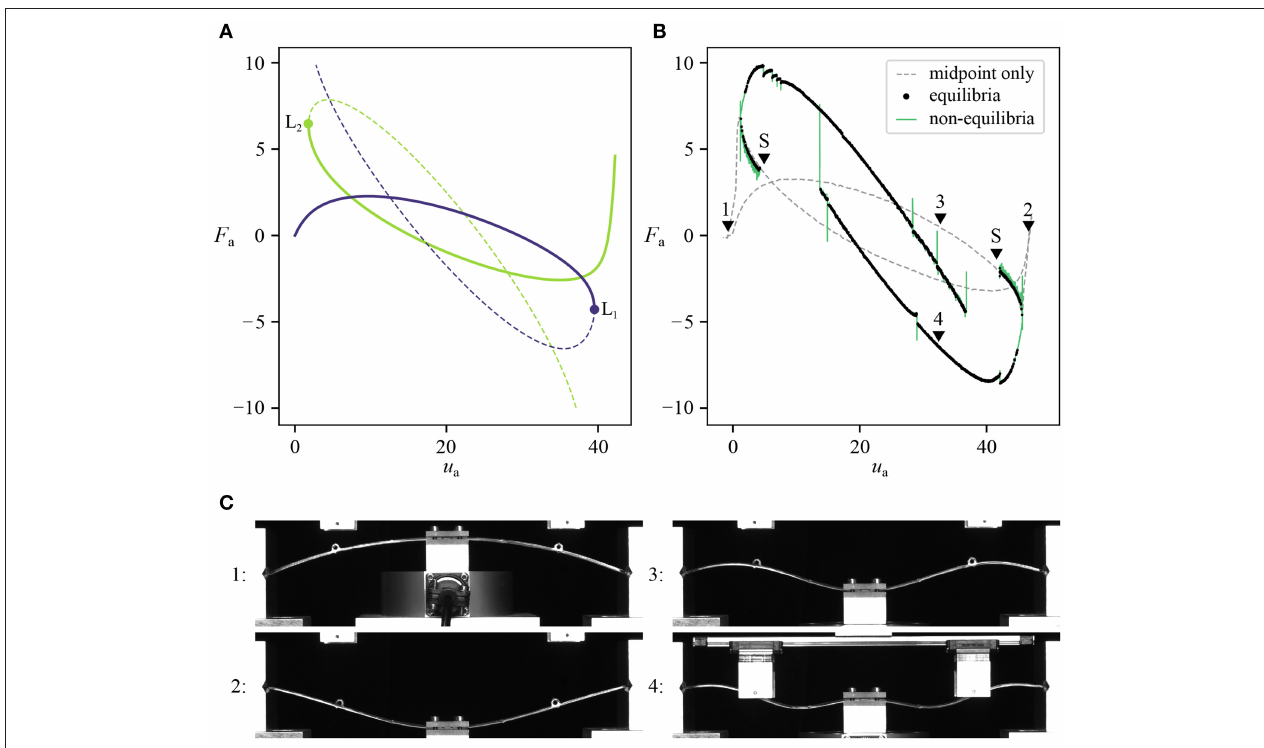
FIGURE 13 | Results of the experimental path-following method. (A) FEA prediction of a subset of the equilibrium curve. Solid and dashed lines indicate stable and unstable segments, respectively. (B) Equilibrium curves obtained in a path-following experiment from Neville et al. [76]. The dashed gray line was obtained using displacement control on the midpoint only. The path-following algorithm was started at the two points marked “S.” Non-equilibria (e.g., for equilibria) are shown in green, and equilibria ( F p < 0.1 N) are indicated by the black dots. (C) Deformation shapes of the arch during the experiment. Shapes 1–4 correspond to the markers 1–4 in (B)